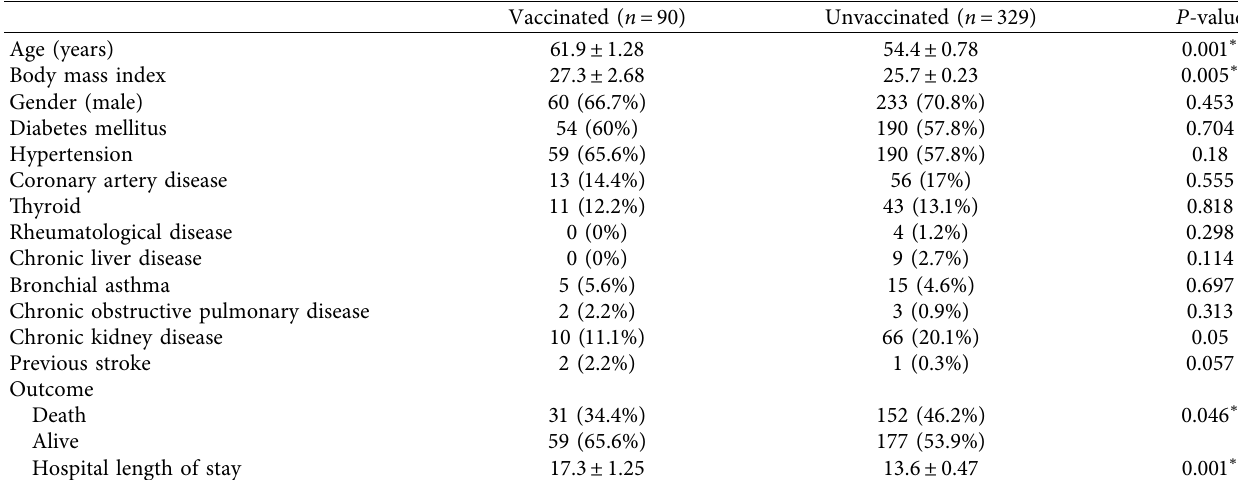
Table 1: Comparison of demographic parameters and clinical outcome between vaccinated and unvaccinated by using t test and chi square